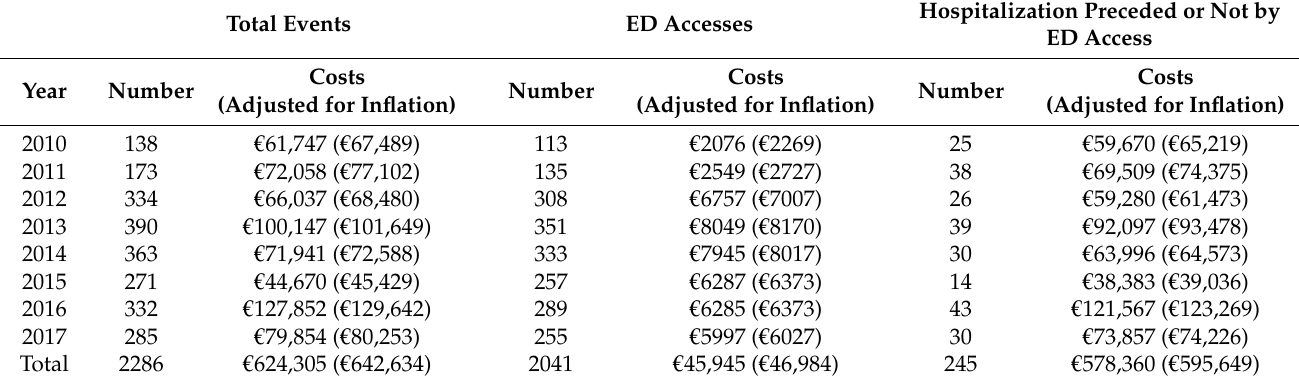
Table 4. Costs of ED accesses/hospitalizations for varicella (adjusted for inflation at December 2017), stratified by year and healthcare